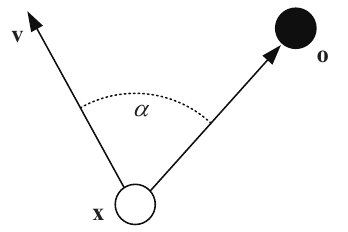
Figure 1. The diagram of the steering angle α